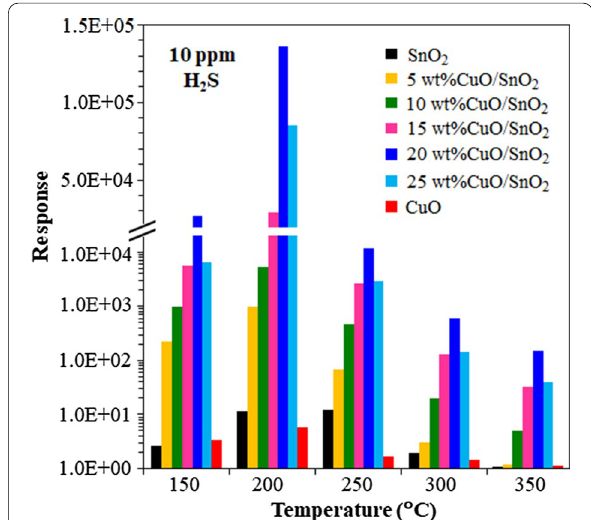
Fig. 9 Effect of working temperature on response to 10 ppm H 2 S of CuO, SnO 2 and 5–25 wt%CuO/SnO 2 sensors